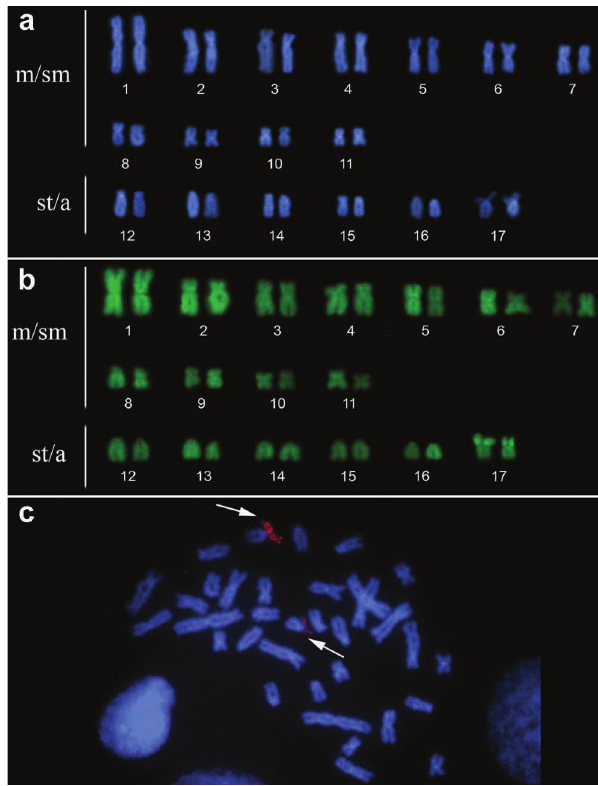
Fig. 7. (a) DAPI fluorescent banding coinciding with C banding. (b) CMA fluorescent banding is coincident with 3 the NOR region on short arm of pair 17 of Eigenmannia sp. “A”. (c) FISH with 18S rDNA probes hybridizing on the short arm of chromosome 17